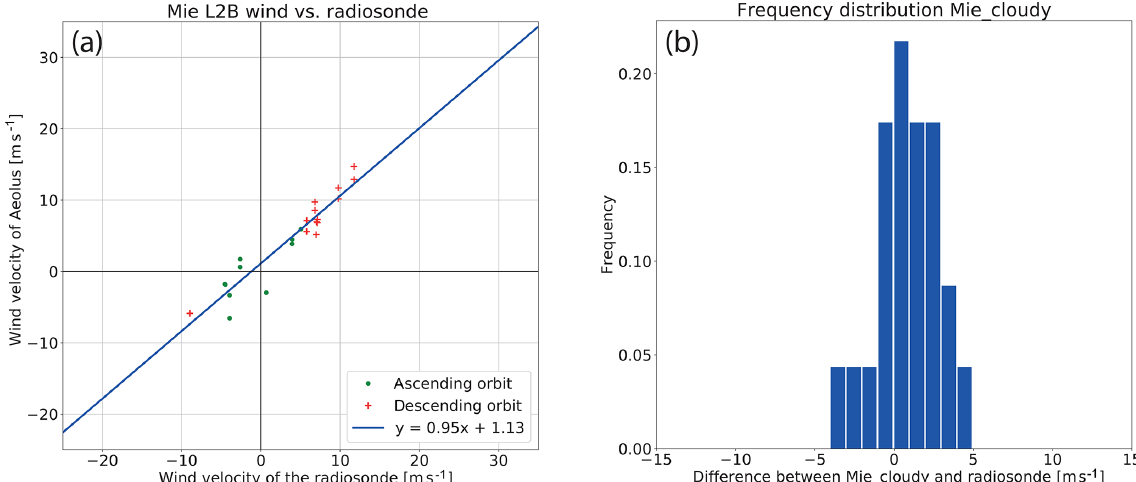
Figure 11. (a) L2B Mie cloudy winds versus the radiosonde measurements made during the ship-borne validation except for 27 November 2018. (b) Frequency distribution of the difference between Mie cloudy and radiosonde wind speeds for the same data set. Radiosonde data are aggregated to the Aeolus vertical resolution and projected to the HLOS of Aeolus. Table 2. Overview of derived biases (systematic errors), the median absolute deviation (MAD), and the scaled MAD (which is an indicator for the random error) for both the Rayleigh clear and Mie cloudy winds obtained from the comparison with the five radiosonde launches. All values are in meters per second (ms − 1 ). Wind type Mean Median Regression Regression MAD Scaled bias bias bias